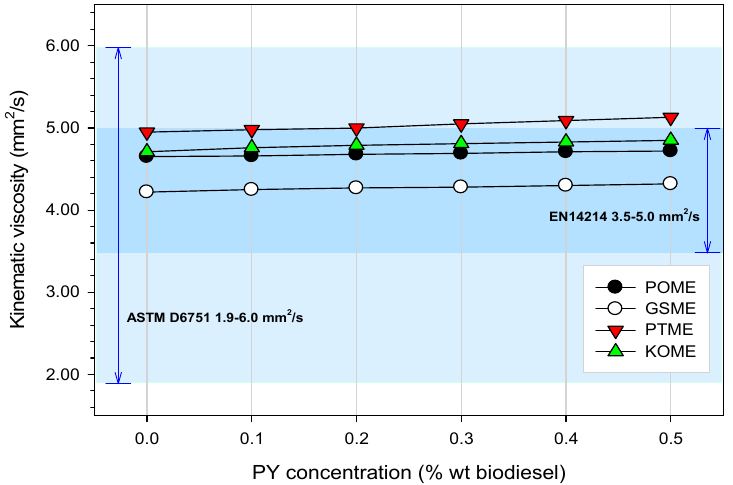
Figure 2. E ff ects of di ff erent PY concentrations on the kinematic viscosity of Figure 2. Effects of different PY concentrations on the kinematic viscosity of biodiesel.